Question: Provide a one-line summary of what is displayed.
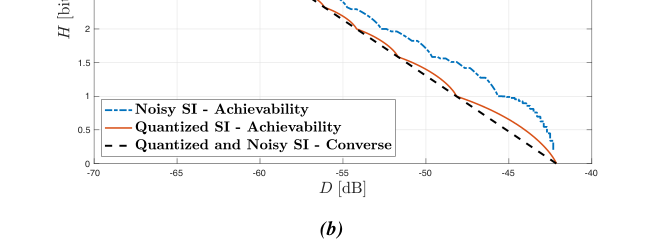
Answer: Upper and lower bounds of entropy–distortion trade-off for quantized and noisy SI case for (a) K = 1/α = 4 and (b) K = 1/α = 32.